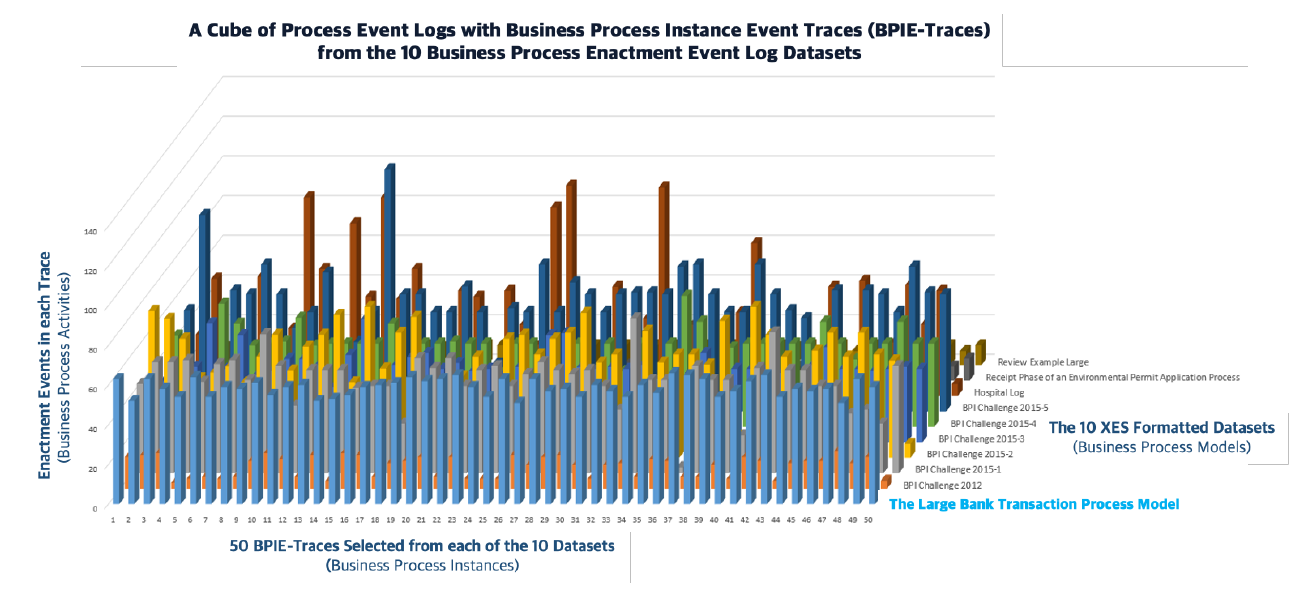
Figure 2. The temporal workcase cube of business process enactment event logs from the 10 XES- formatted